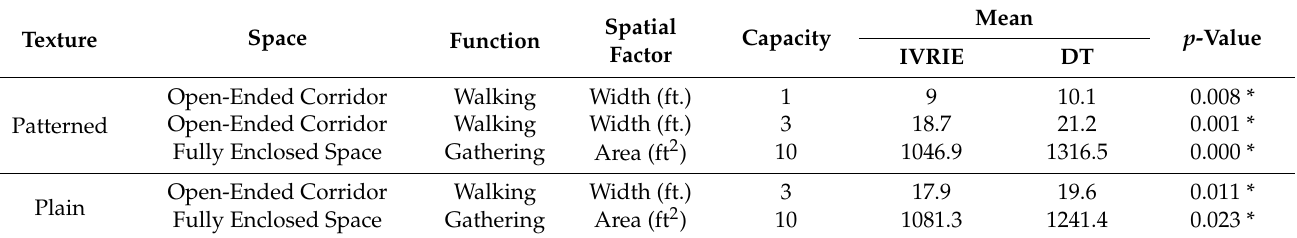
Table 13. The average size of spaces designed in each